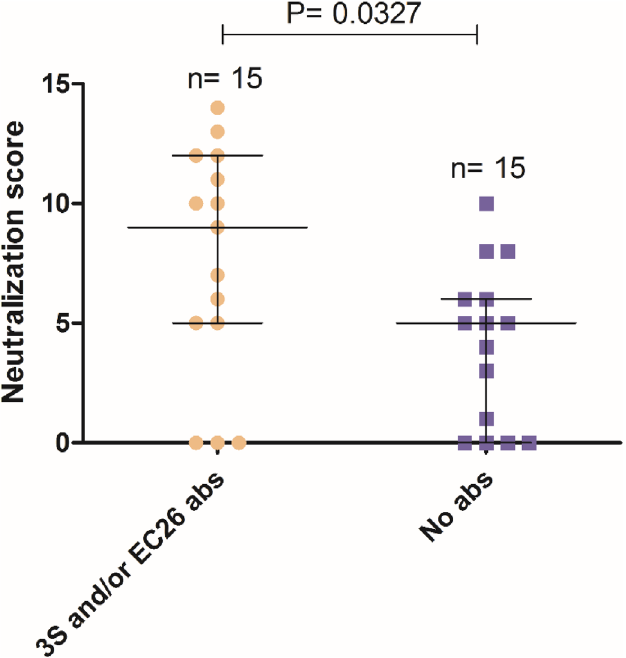
Figure 6. Neutralizing scores in patients with and without 3S or EC26 antibodies. Lines denote median and interquartile range. Statistical significance was determined using the Mann–Whitney test.